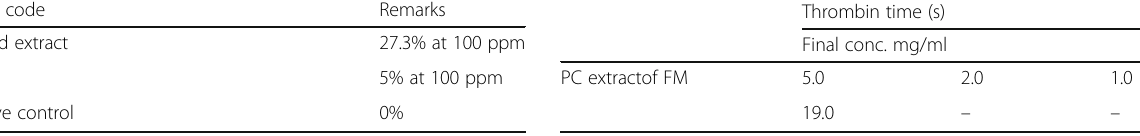
Table 2 Cytotoxic activity of FM phenolic extracts Sample code